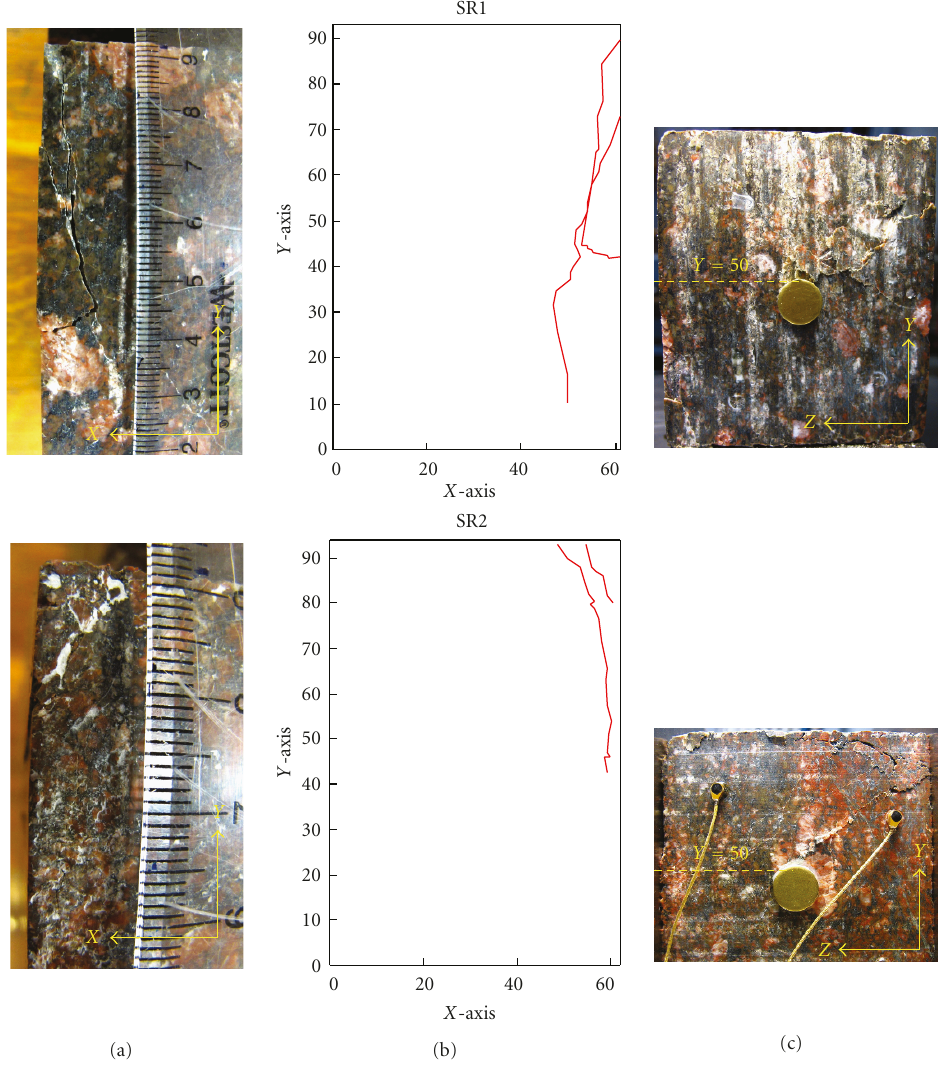
Figure 13: (a) Photos of the observed cracks at the upper part of the free surface ( X = 62 mm). (b) The observed cracks mapped onto X - Y plane, where the free surface is on the right-hand side ( X = 62 mm). Note that the cracks on SR2 sample are hairline thin. (c) Photos of the observed cracks on the Z = 80mm